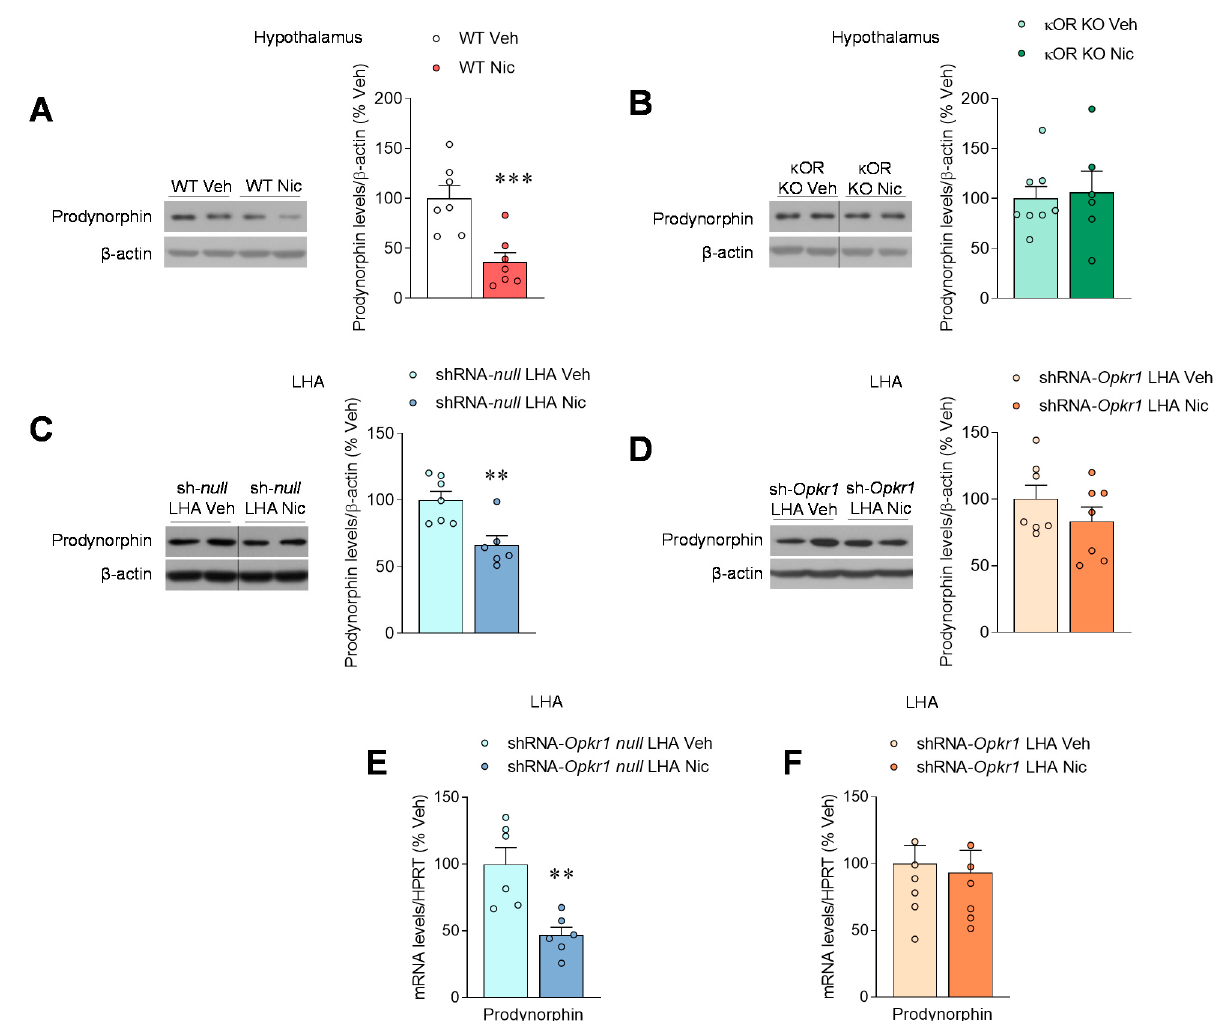
Figure 3. Nicotine effects on prodynorphin in the LHA. ( A , B ) Protein levels of prodynorphin in the hypothalamus ( n = 6–8 mice/group) of WT ( A ), or κ OR KO ( B ), mice treated SC with vehicle or nicotine through osmotic minipumps for 14 days. ( C , D ) Protein levels of Prodynorphin in the LHA ( n = 6–7 rats/group), ( E , F ) mRNA levels of prodynorphin in the LHA ( n = 6–8 rats/group), of rats stereotaxically treated within the LHA with shRNA- null ( C , E ) or shRNA -Opkr1 ( D , F ) adeno-associated viruses and treated SC with vehicle or nicotine through osmotic minipumps for 14 days. ** p < 0.01 vs. *** p < 0.001 vehicle. Data are expressed as mean ± SEM. The bands in gels from panels B and C have been spliced from the same original gels.